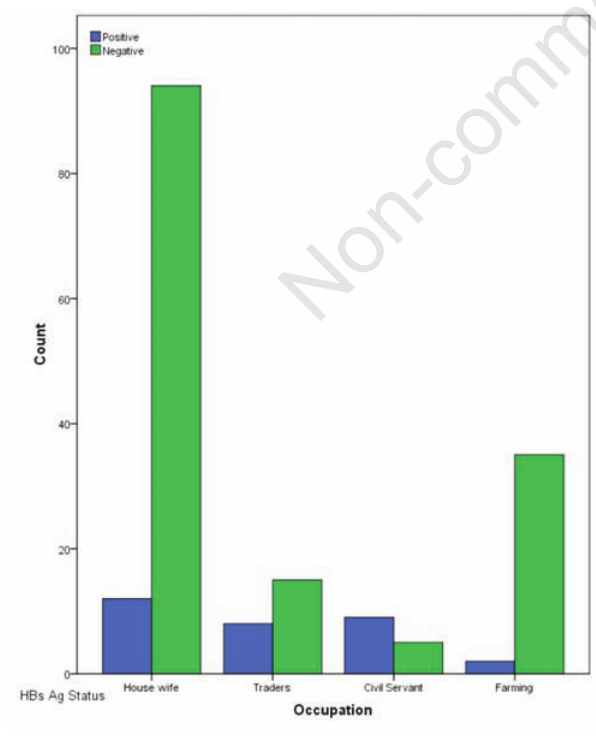
Figure 4. Distribution of hepatitis B surface antigen among preg- nant women with respect to